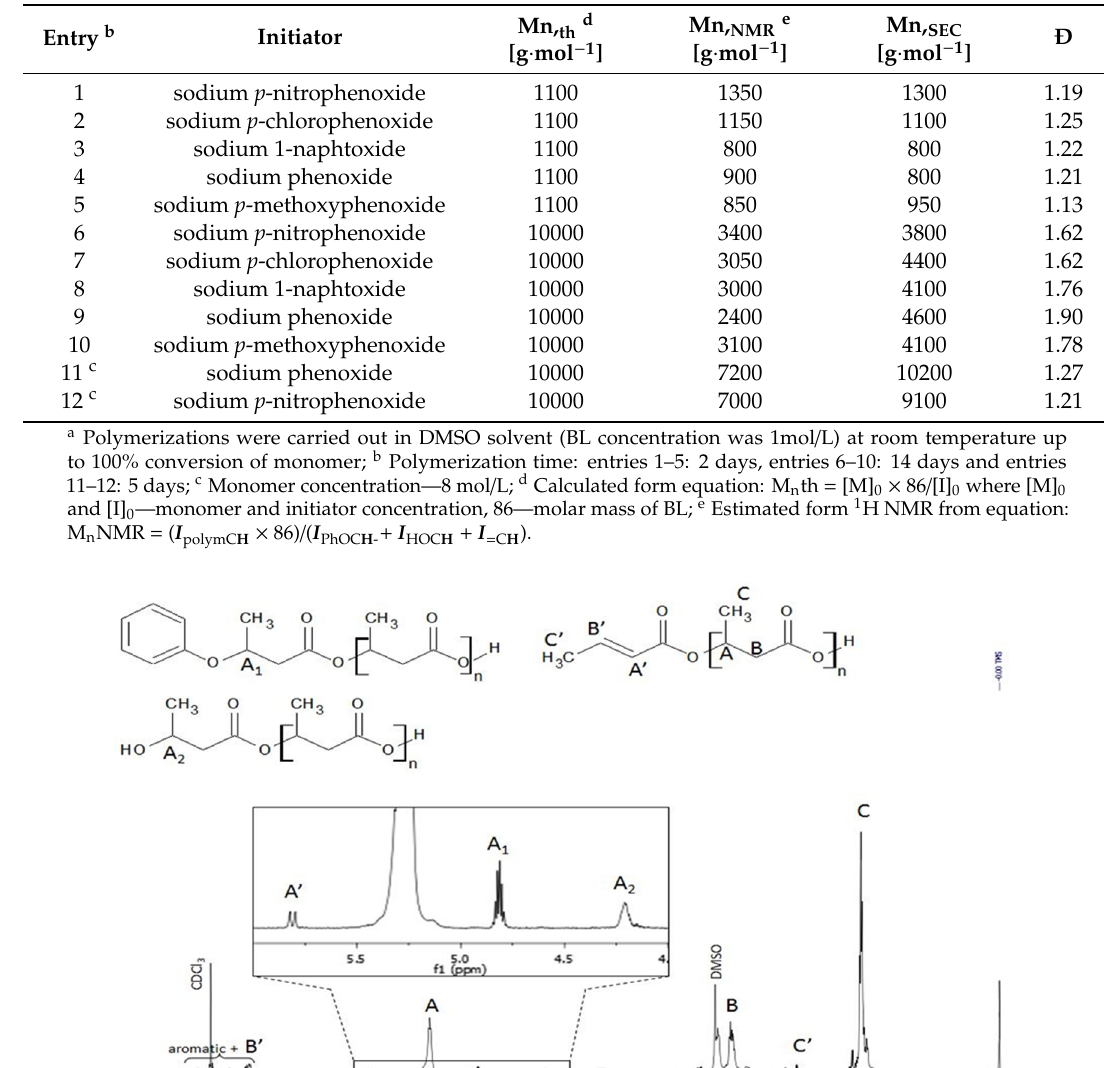
Table 1. Results of BL polymerization initiated with selected sodium phenoxides a .